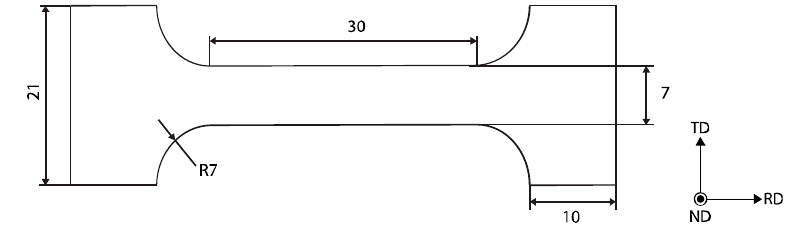
Figure 3. Dimensions of the specimens for the tensile test in mm. The tensile samples were cut based on the ASTM-E8M standard and the experiments were carried out at 2.77 × 10 − 4 s − 1 .